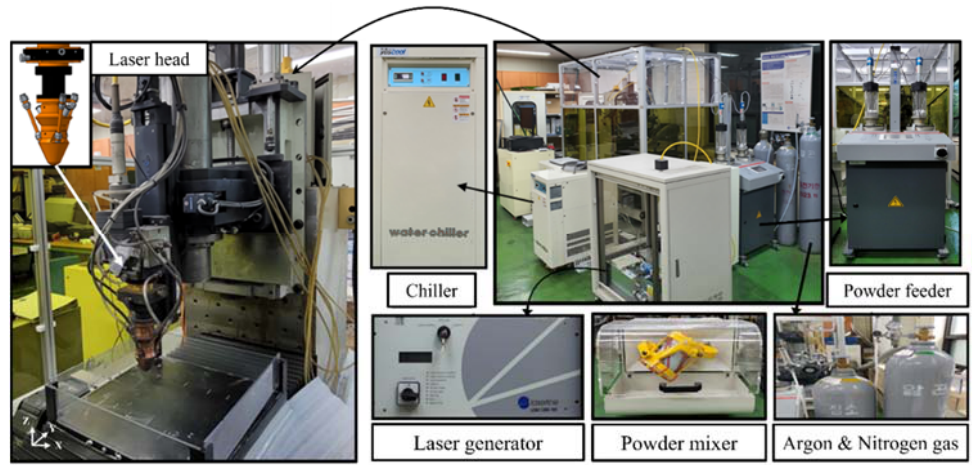
Figure 4. The experimental set-up for DED. Table 2. The chemical compositions of the substrates.